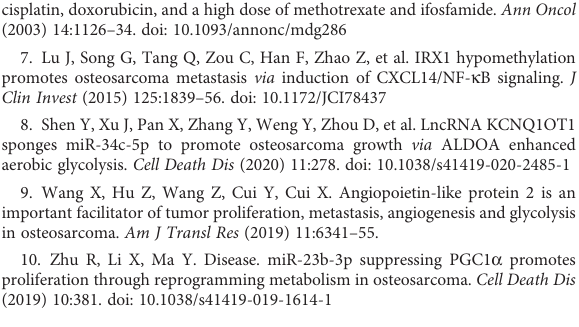
SUPPLEMENTARY TABLE 2 Multivariate Cox regression